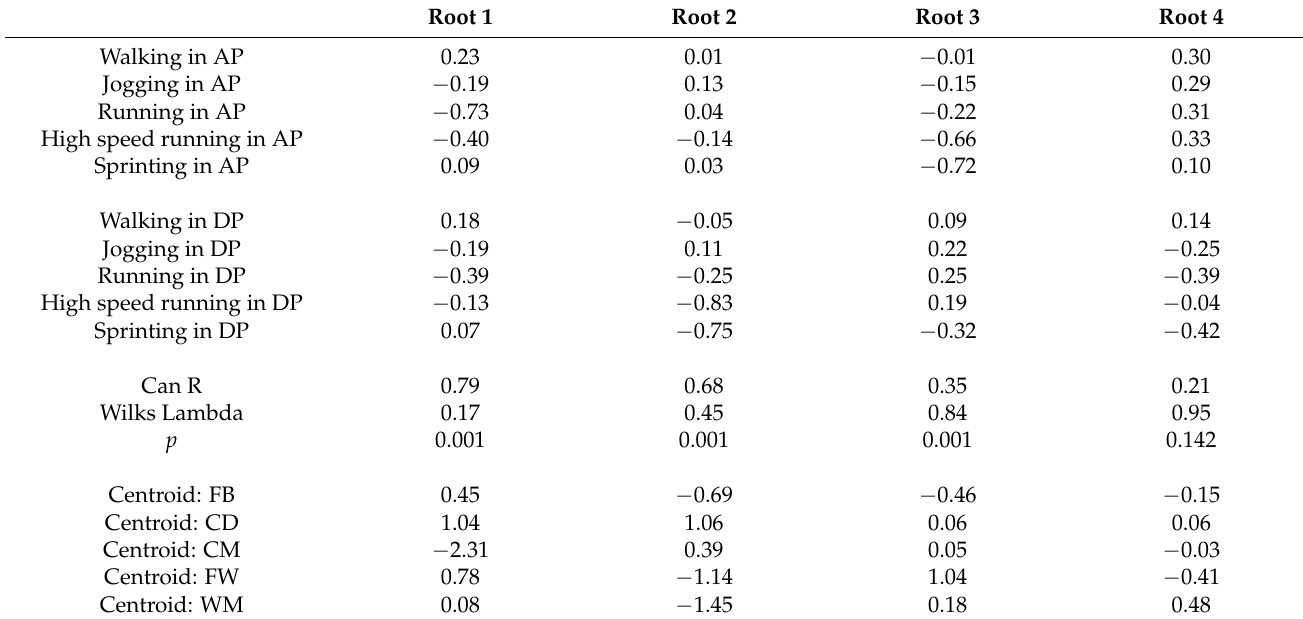
Table 2. Multivariate difference in RP in AP and DP of game among players at different playing